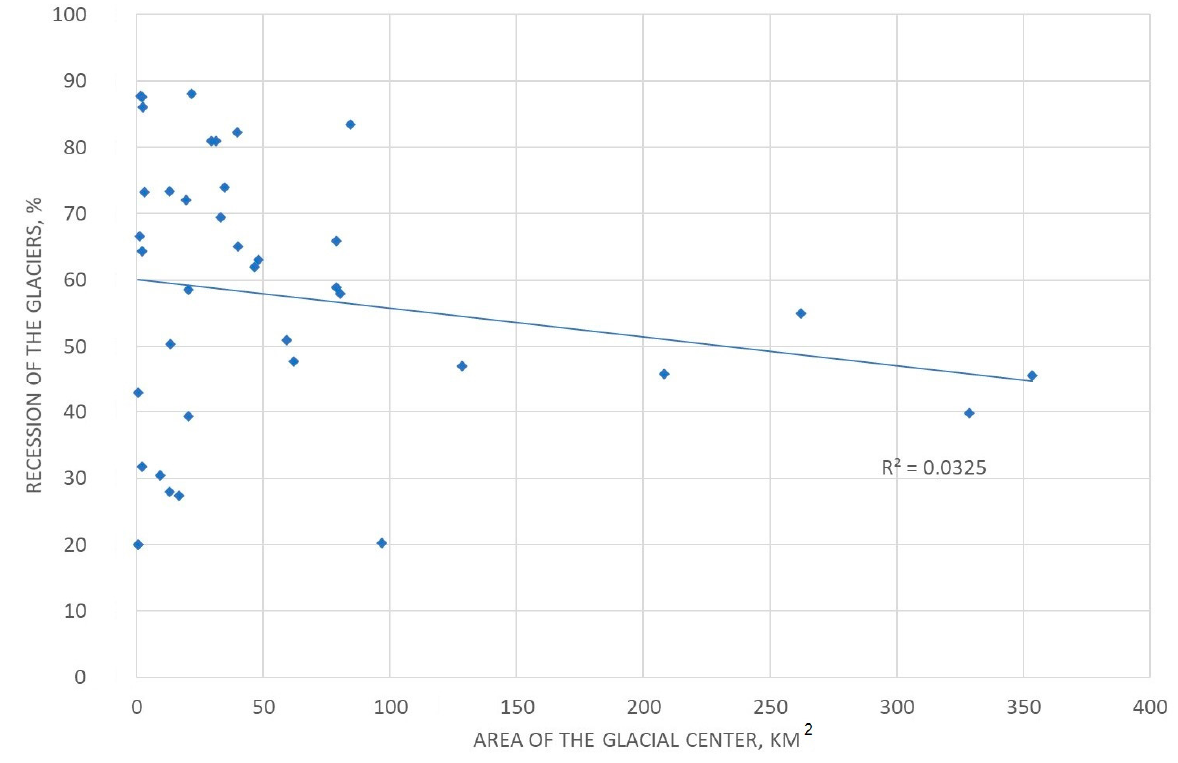
Figure 8. Relationship between the areas of glacial centers at the LIA maximum and the decrease in their area after the LIA maximum, %.